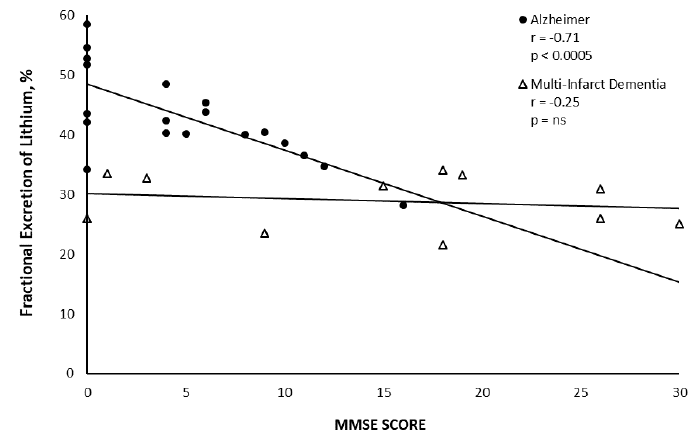
Figure 6. Graph showing the relationship between fractional excretion of lithium (FElithium) and mini mental state examination (MMSE) scores in patients with Alzheimer’s disease and multi − infarct dementia. Note the increasing FElithium as MMSE is decreasing. Because there is a dose response to the natriuretic factor, blood levels of the natriuretic factor either increased or the patient became more dehydrated as the dementia worsened.